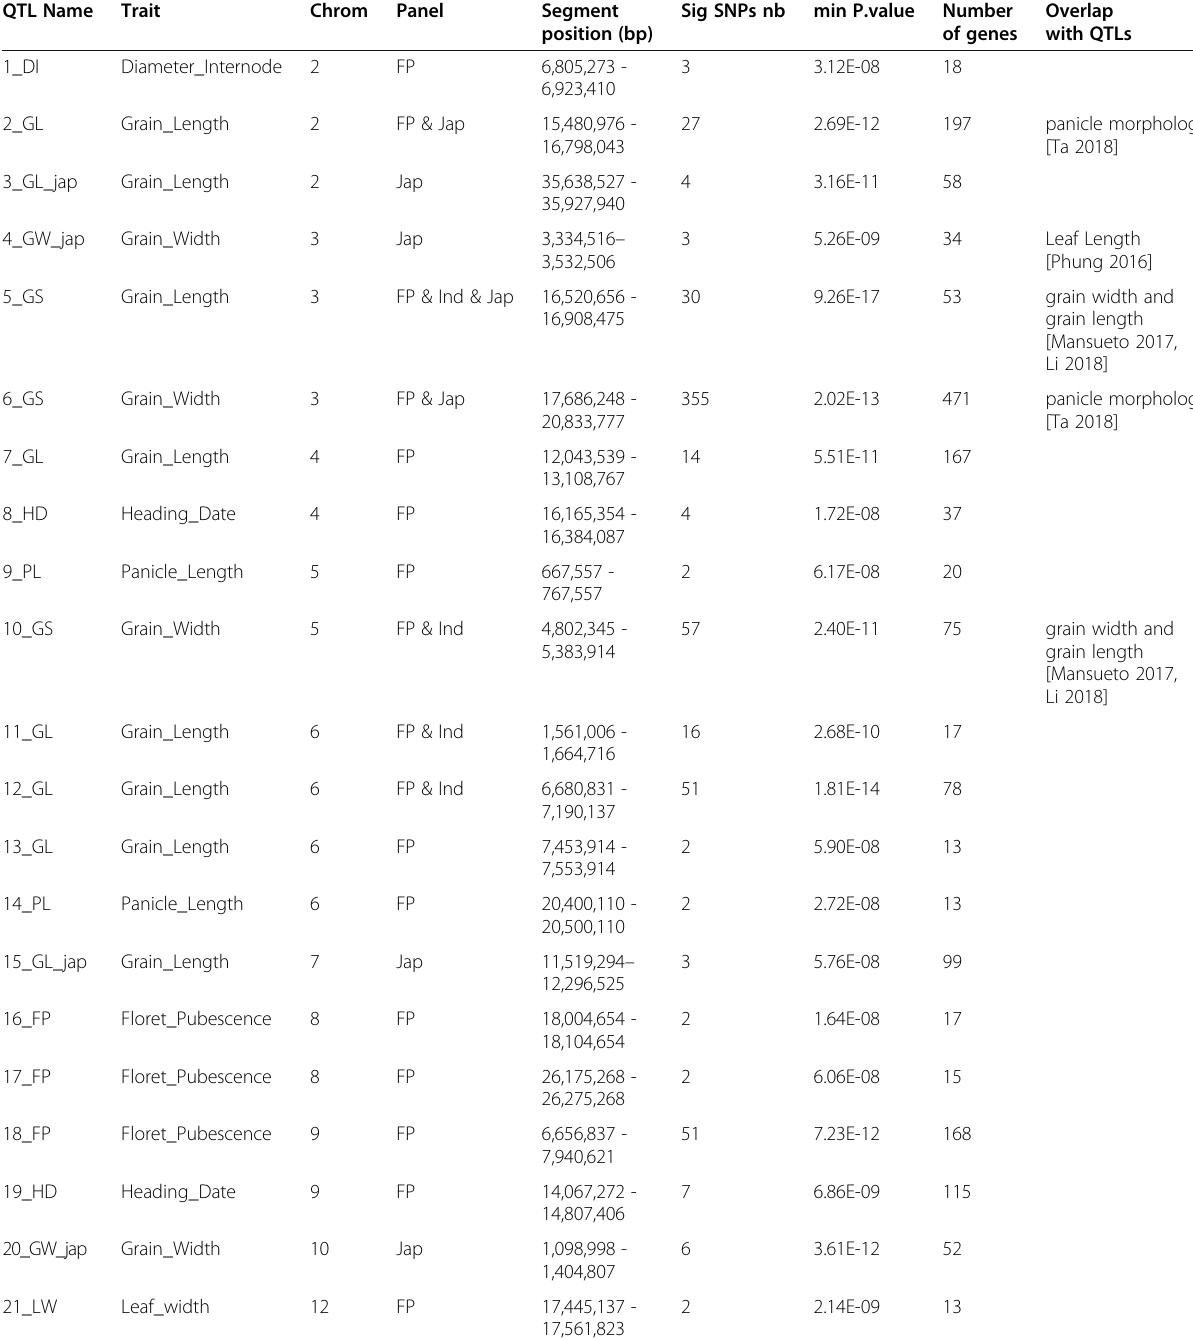
Table 1 21 QTLs identified for plant description traits in the full panel, and Indica and Japonica subpanels. Detailing for the QTL analysis; significance threshold -log 10 ( p value) ≥ 8.0; panel in which significant associations were detected, highest level of significance for all panels and overlaps with publish QTLs for Vietnamese rice populations or for the 3 K